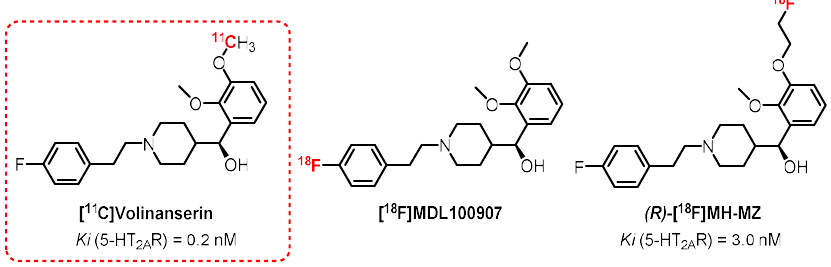
Figure 7. Volinanserin analogues as 5-HT 2A R radiotracers.